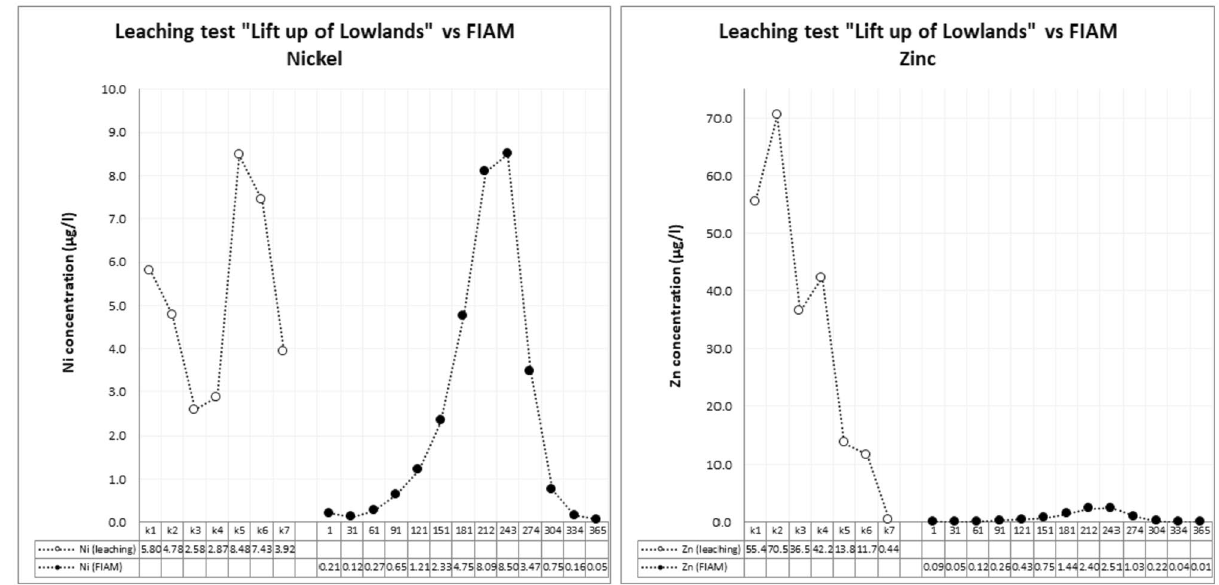
Fig. 7 Left figure, the measured nickel eluate and FIAM model concentrations in µg/l (y-axis) versus the eluate fraction (k1–k7)/time period in year two (days). Right figure, the results for zinc